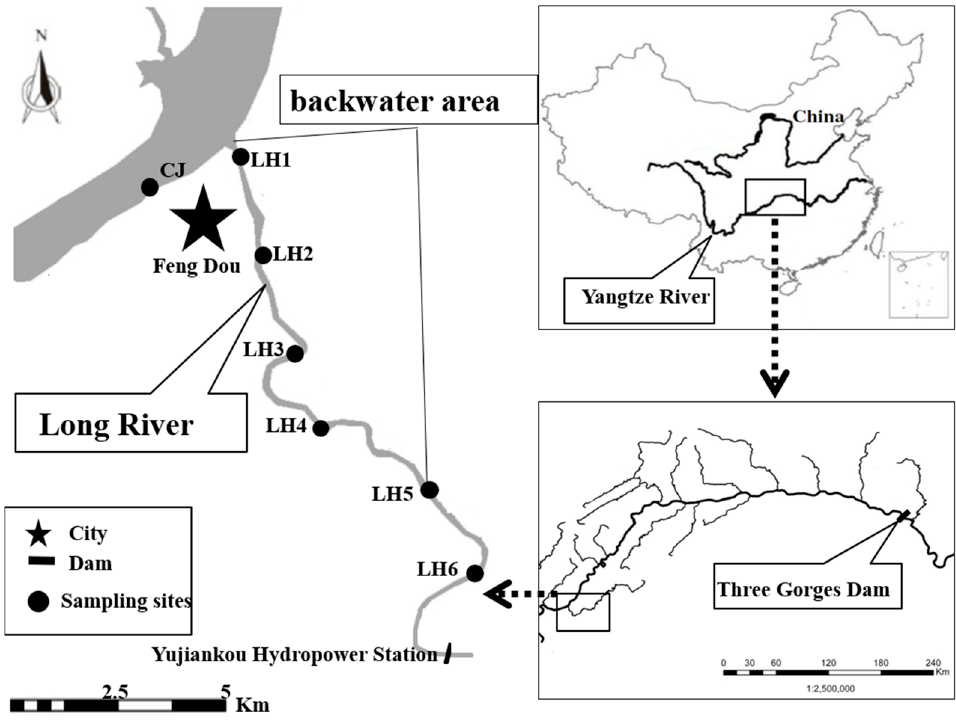
Figure 1. Sampling sites distribution map of the Long River (LR).